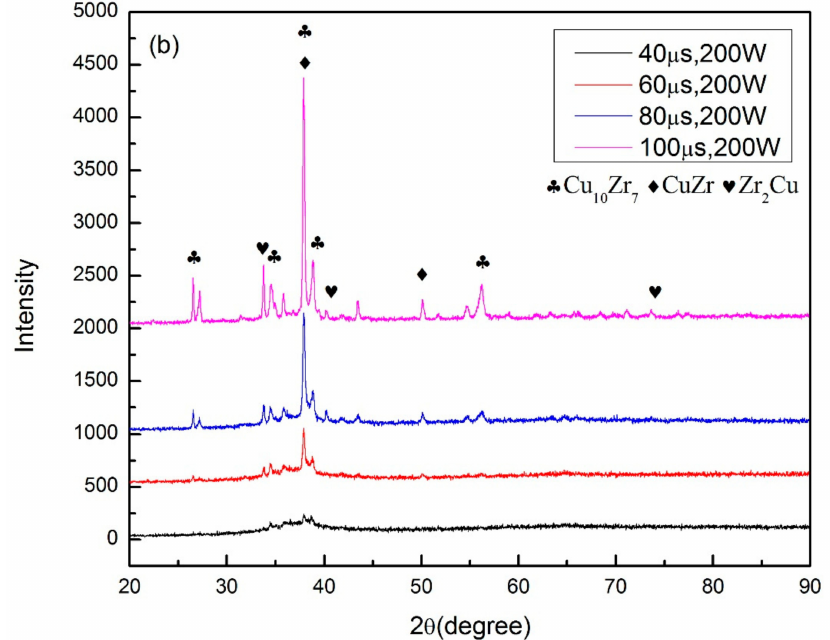
Figure 5. XRD patterns of ( a ) di ff erent laser power with same exposure time; ( b ) di ff erent exposure time with same laser power.